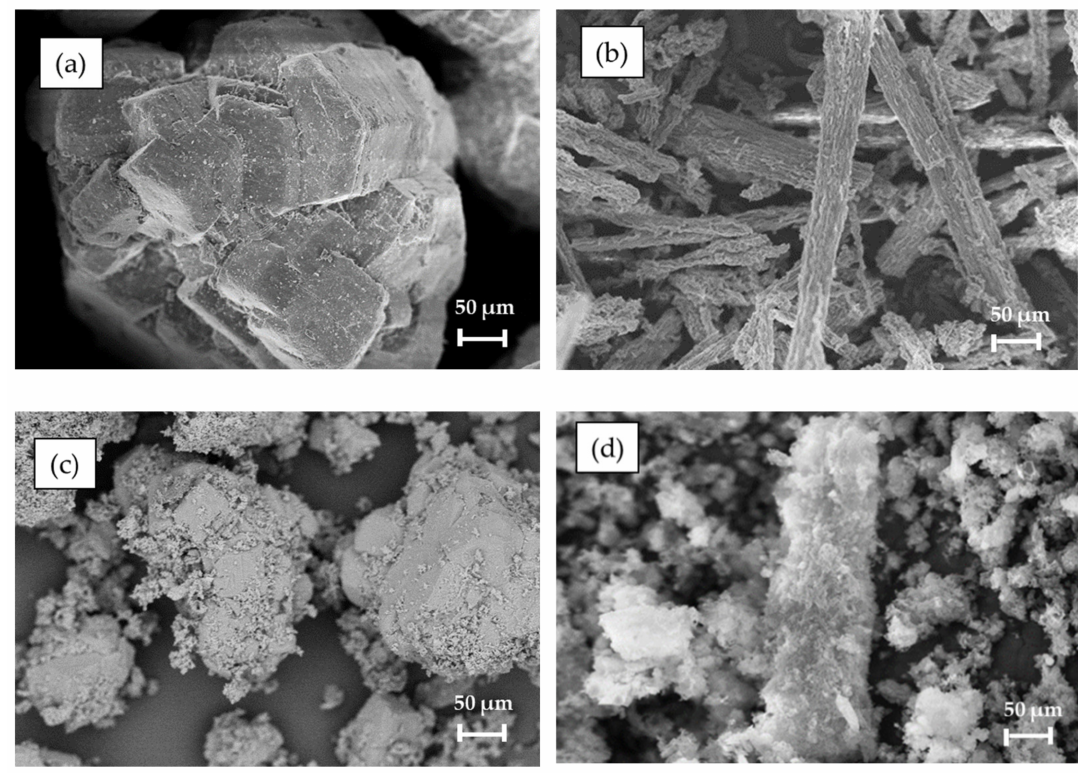
Figure 3. FESEM images of ( a ) Al 2 O 3 ( b ) SBA-15 ( c ) CZMNZA ( d ) CZMNZS.